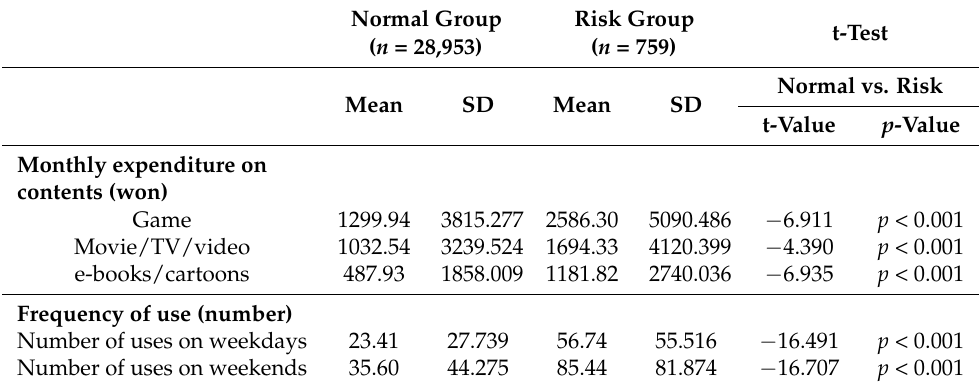
Table 5. Smartphone Usage